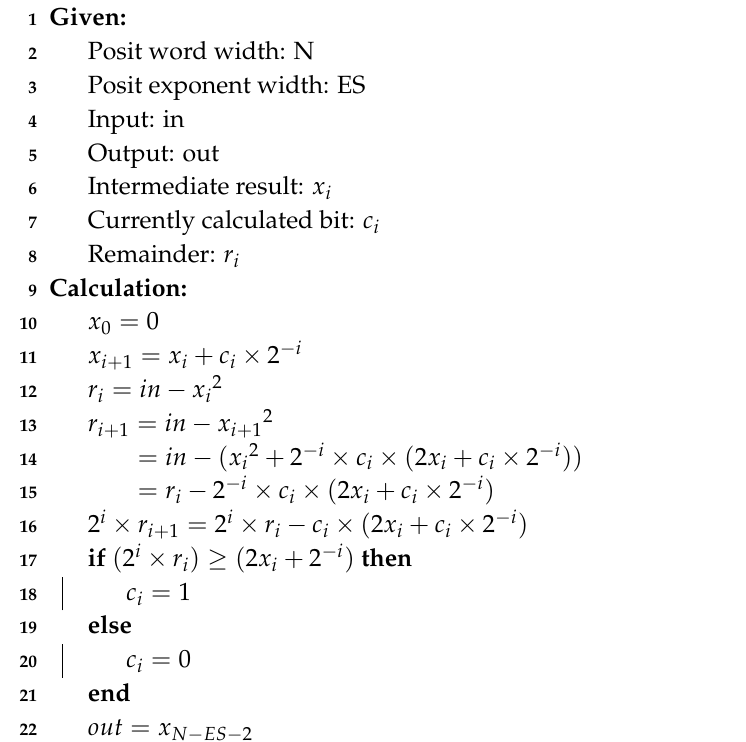
Algorithm 3: The iteration process of the square root.